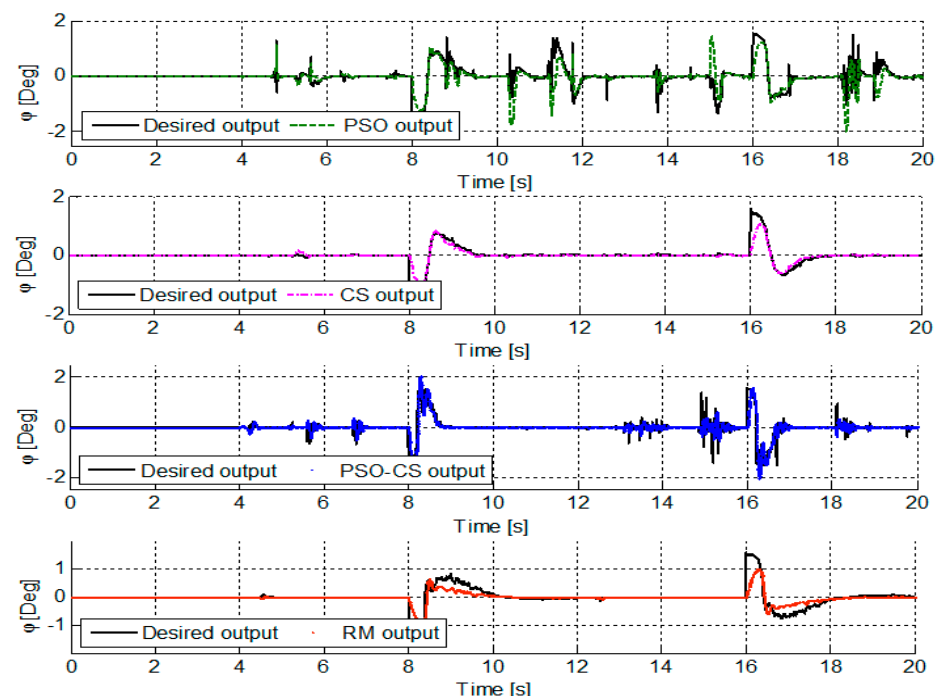
Figure 13. Quadrotor’s roll attitude ( ϕ ) using Particle Swarm Optimization (PSO), Cuckoo Search (CS), Particle Swarm Optimization-Cuckoo Search (PSO-CS), and Reference Model (RM) with disturbance (rectangular trajectory).